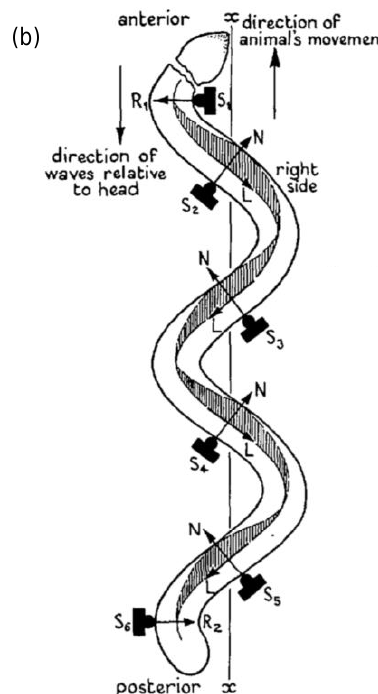
Figure 4. Illustration of ( a ) the curvature and shear waves approximating the flagellum undulating motion, with permission from Brokaw [63], ( b ) the tangential and normal forces (resistance forces) along the flagellum motile body, with permission from Gray [66].